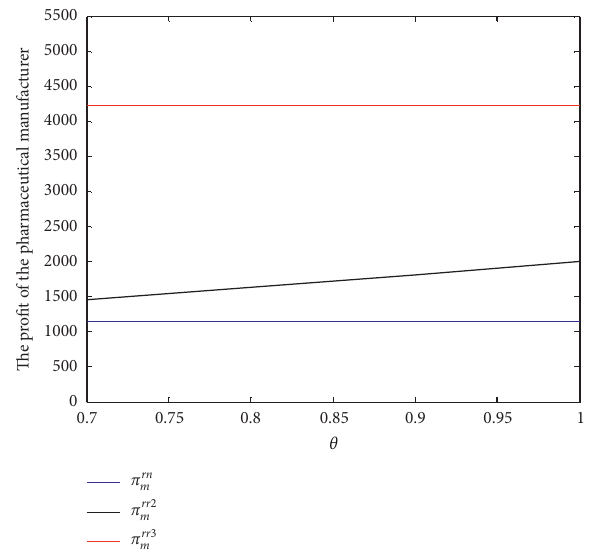
Figure 1: The profit of the pharmaceutical manufacturer under retailer price cap regulation.